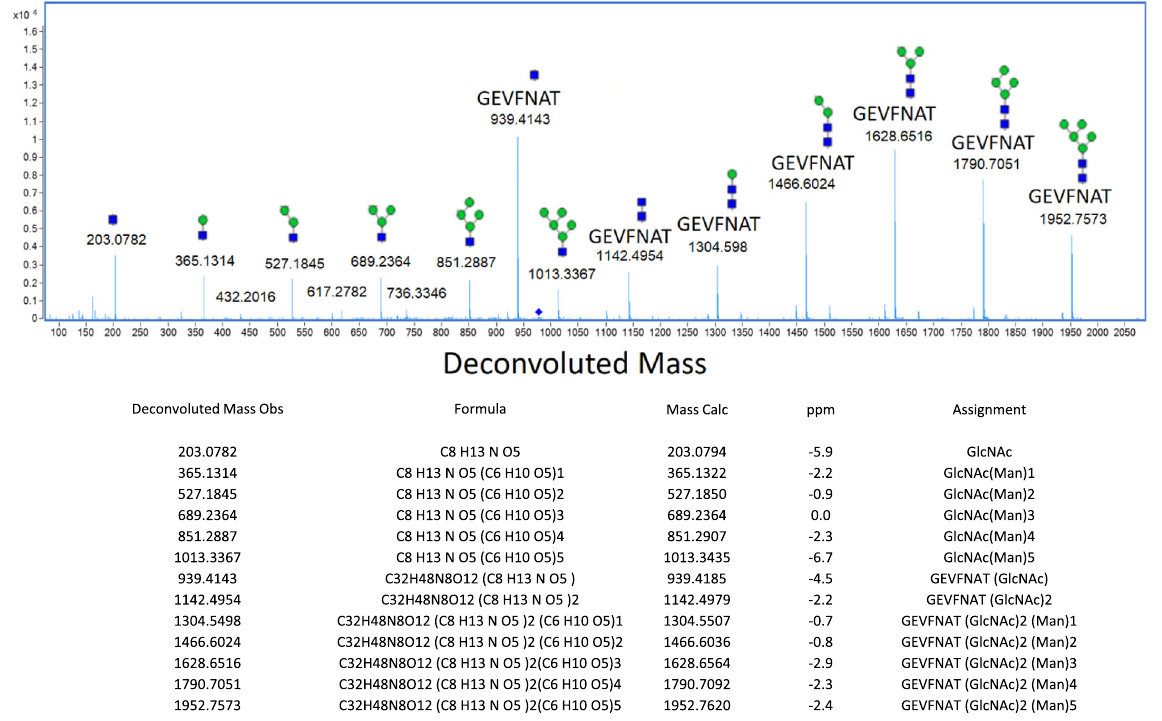
Fig. 5 Complete glycan fragmentation series for RBD glycopeptide GEVFNAT-Man5 (N343). Complete glycan fragmentation series for RBD glycopeptide GEVFNAT-Man5 (N343) with calculated mass errors. Glycan-fragmentation series shows the peptide stump (GEVFNAT-GlcNAc) and mannose ladders. Blue squares indicate N-acetyl glucosamine, green circles indicate